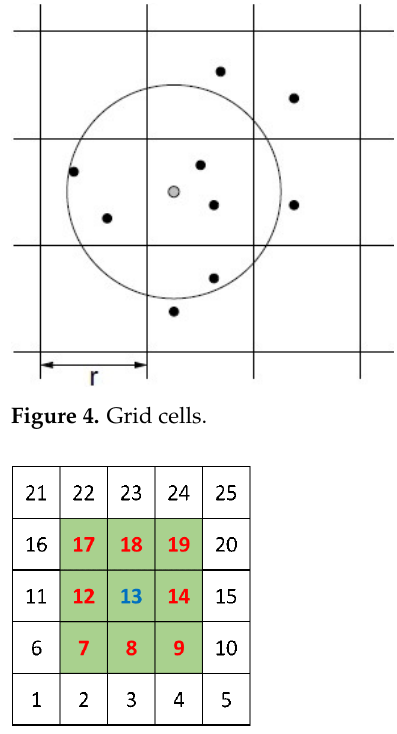
Figure 5. Range query in grid cells